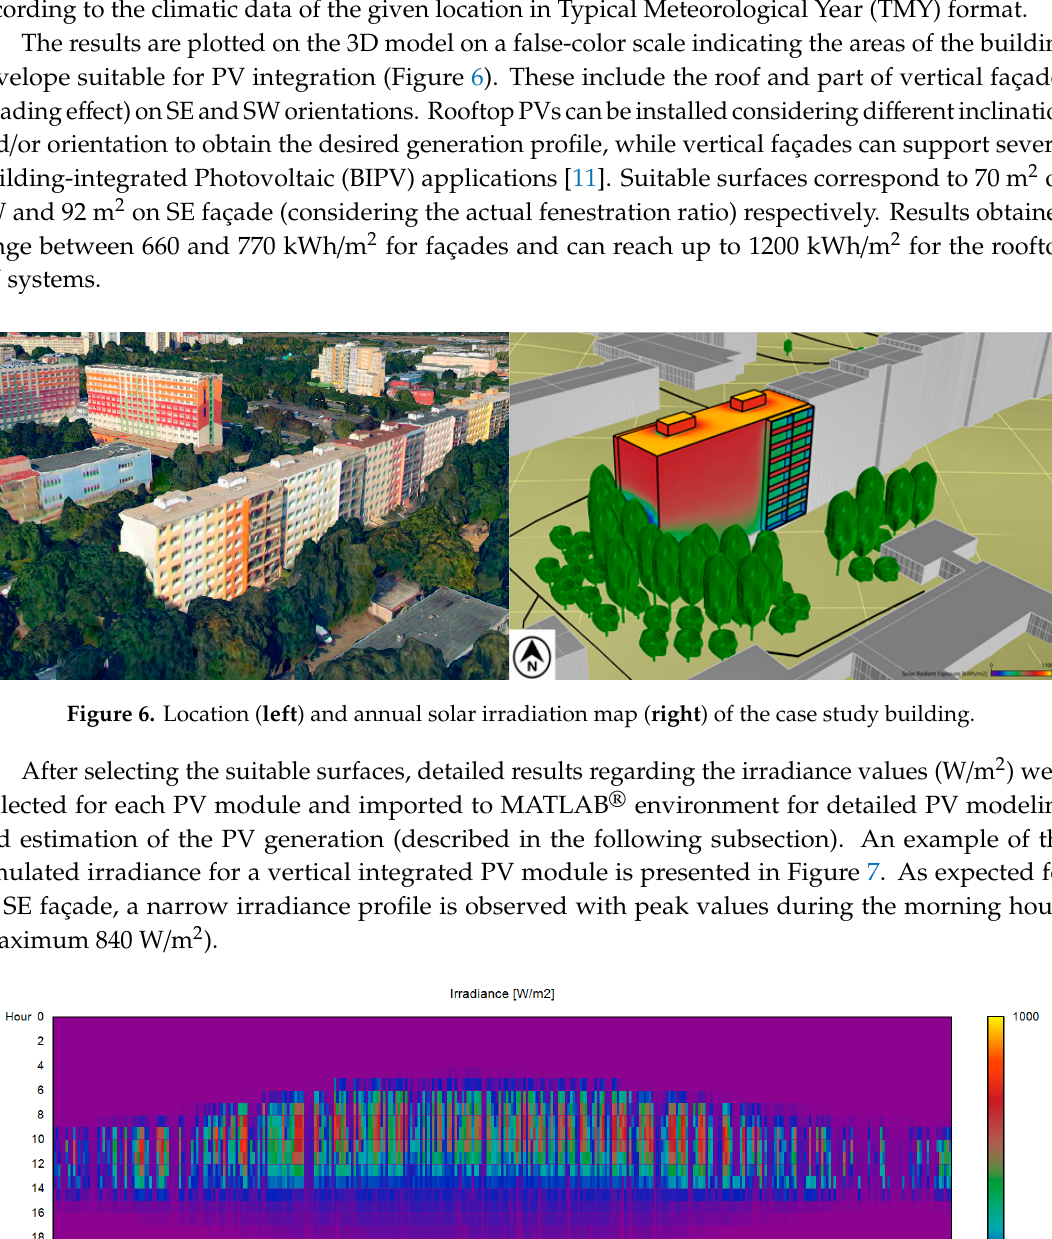
Figure 7. Hourly irradiance profile for vertical integrated photovoltaic (PV) module with Southeast (SE) orientation.